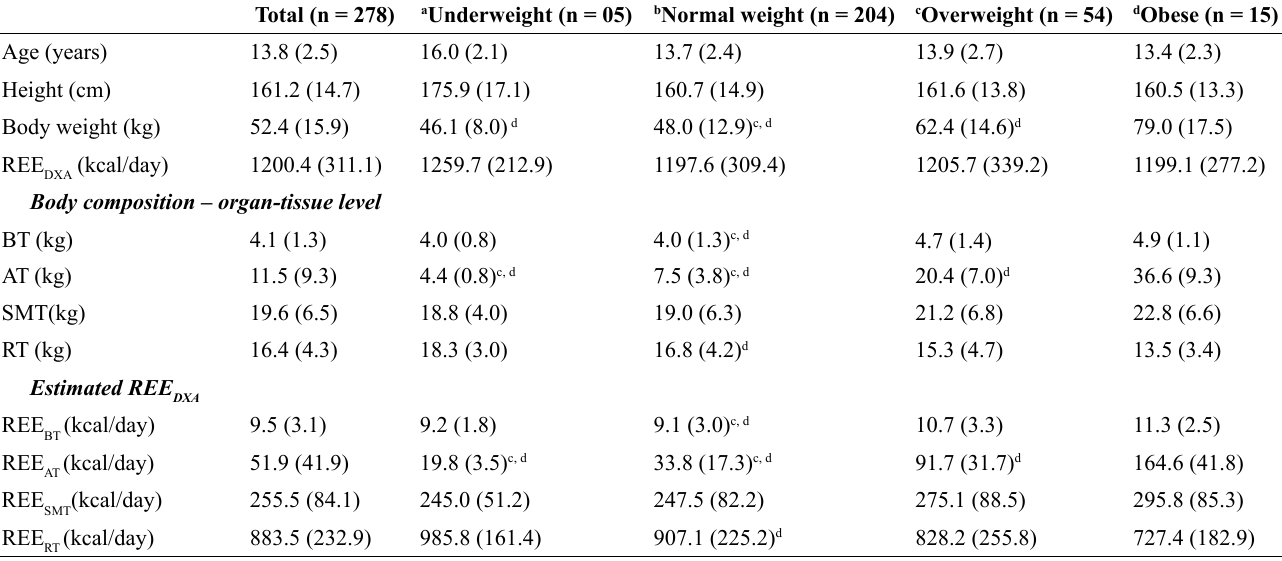
Table 2: Descriptive statistics and Analysis of Variance of body composition and resting energy expenditure of boys classified according to their nutritional